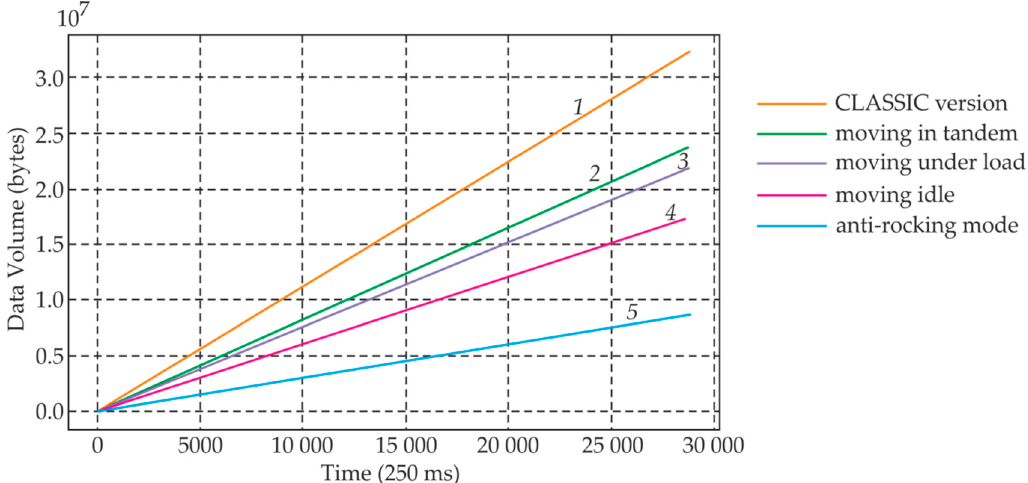
Figure 12. The total amount of data transmitted in different modes of the crane operation.